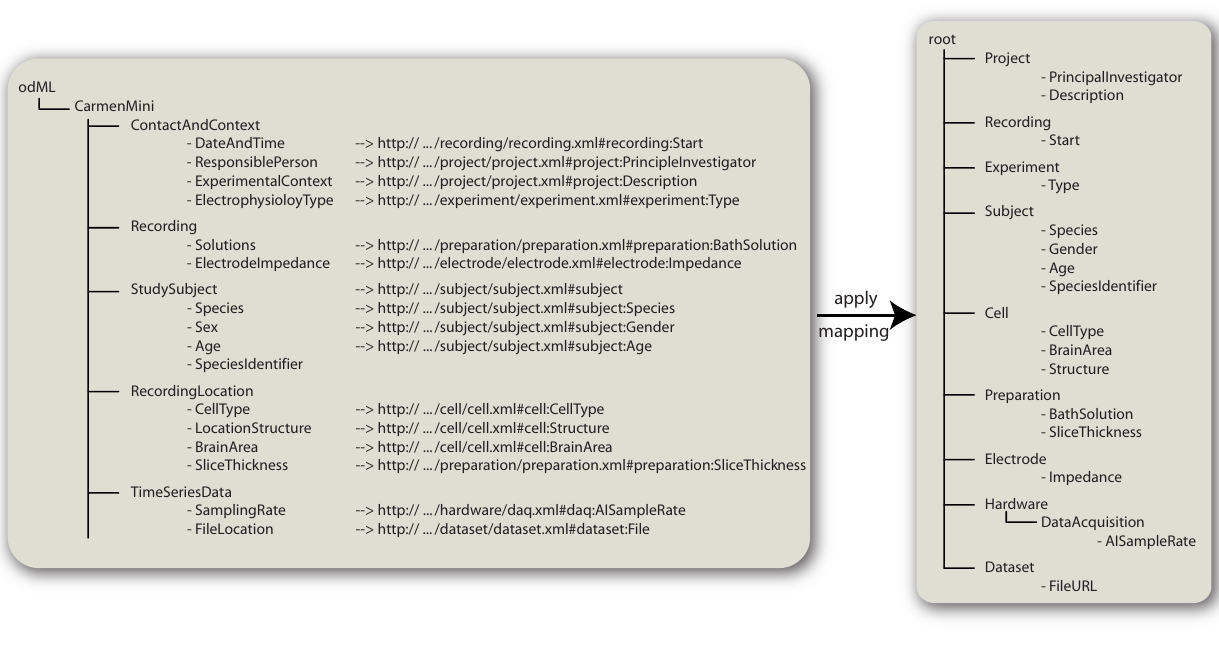
terminology which defines mappings for properties and sections. These are URLs to the respective properties in the od ML-terminologies. Applying this mapping information converts the tree to the layout suggested by the od ML-terminologies (right